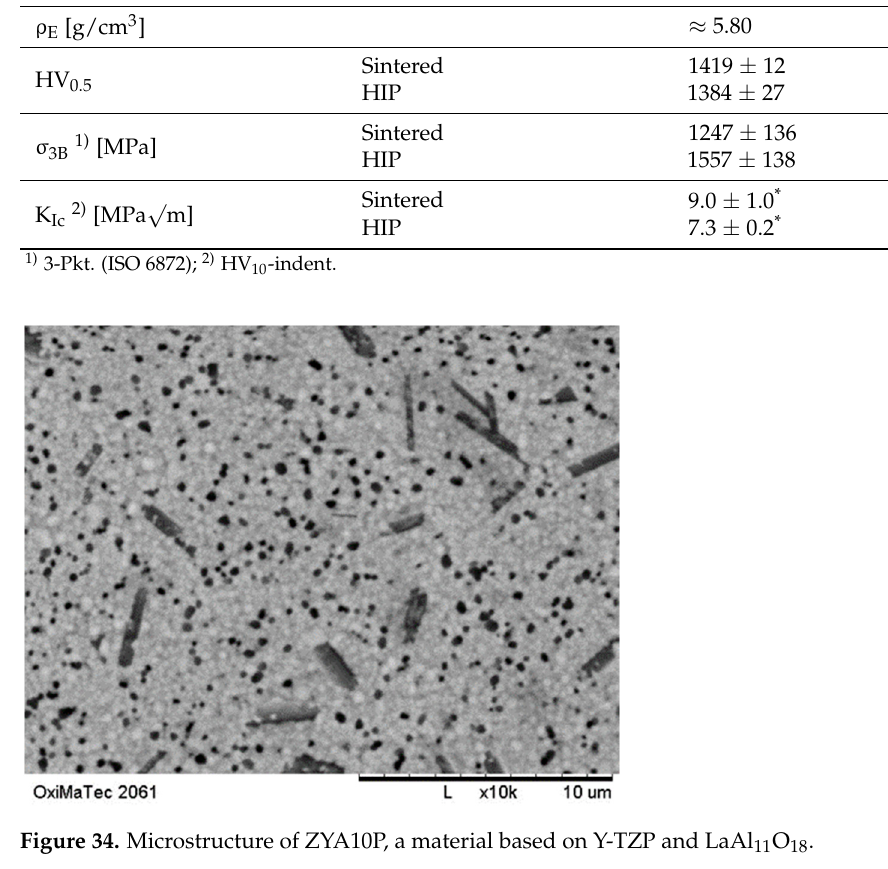
Figure 34. Microstructure of ZYA10P, a material based on Y-TZP and LaAl 11 O 18. Table 6. Typical mechanical properties of